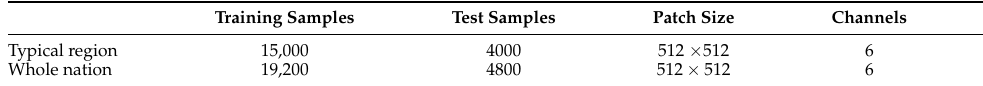
Table 2. Details for the training sets.